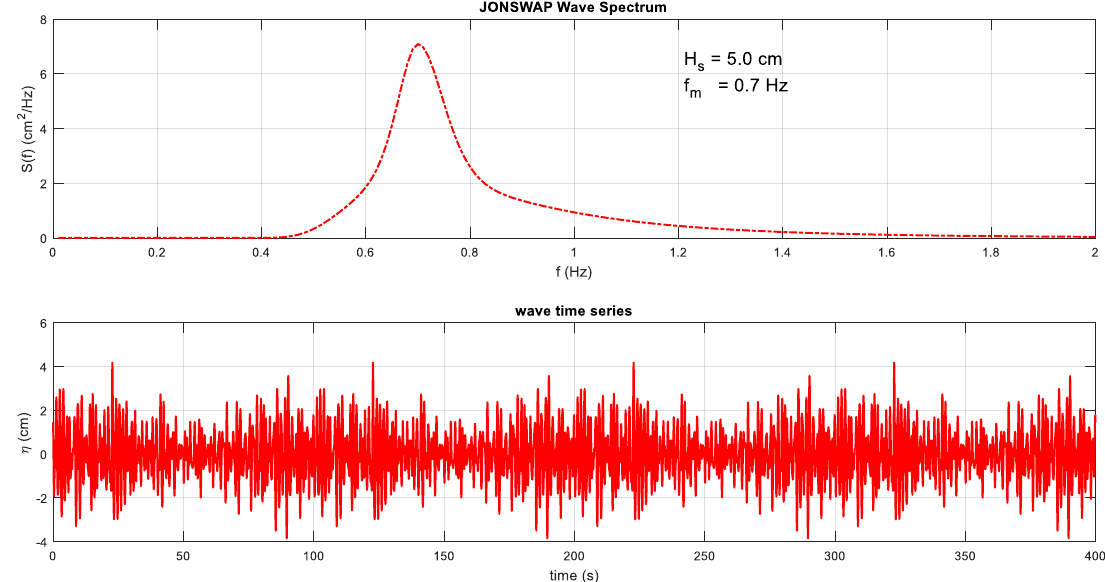
Table 1. The parameters of JONSWAP wave spectrum.